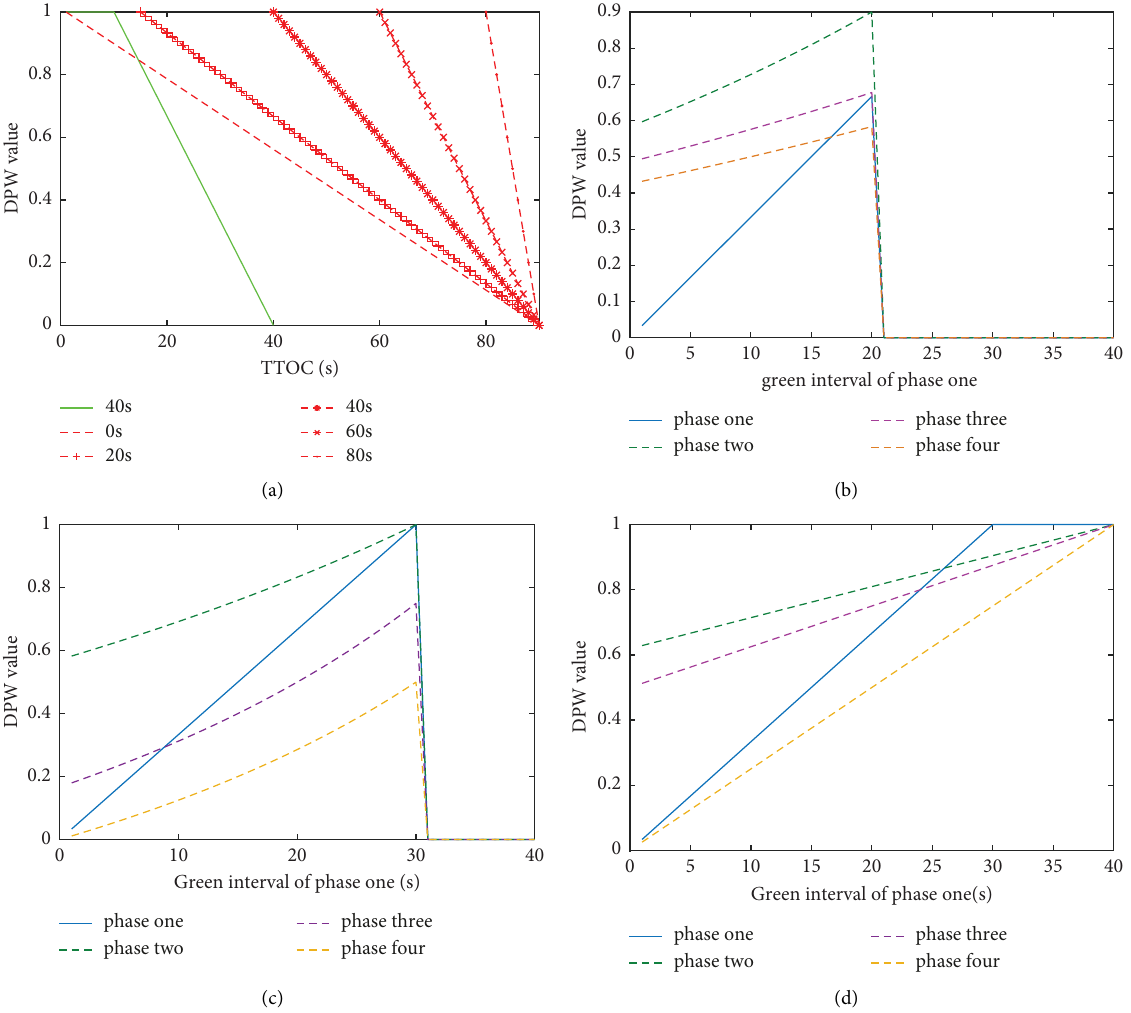
Figure 5: Single-vehicle DPW value with respect to TTOC. (a) Single-vehicle DPW value of phase one. (b) Red truncated at 20 s-TTOC. (c) Red truncated at 10 s-TTOC. (d) Red truncated at 0s-TTOC of phase